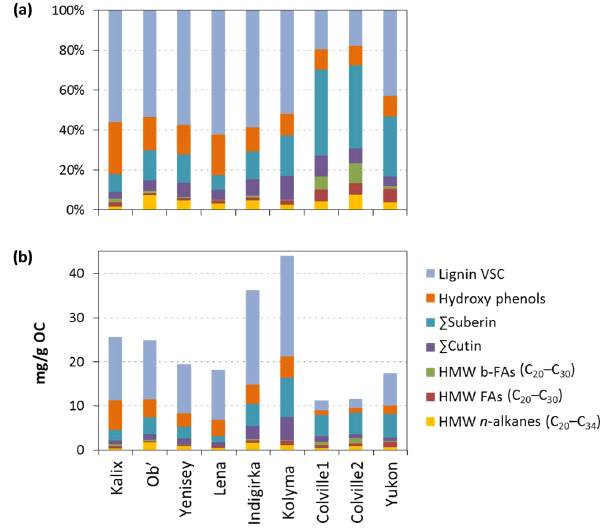
Figure 9. The relative proportion (a) and abundances (b) of various terrestrial biomarkers analyzed in the pan-Arctic sediments. VSC: vanillyl, syringyl and cinnamyl phenols; HMW: high-molecular- weight; b-FAs: bound fatty acids; P Suberin and P Cutin: suberin and cutin biomarkers as defined in Table